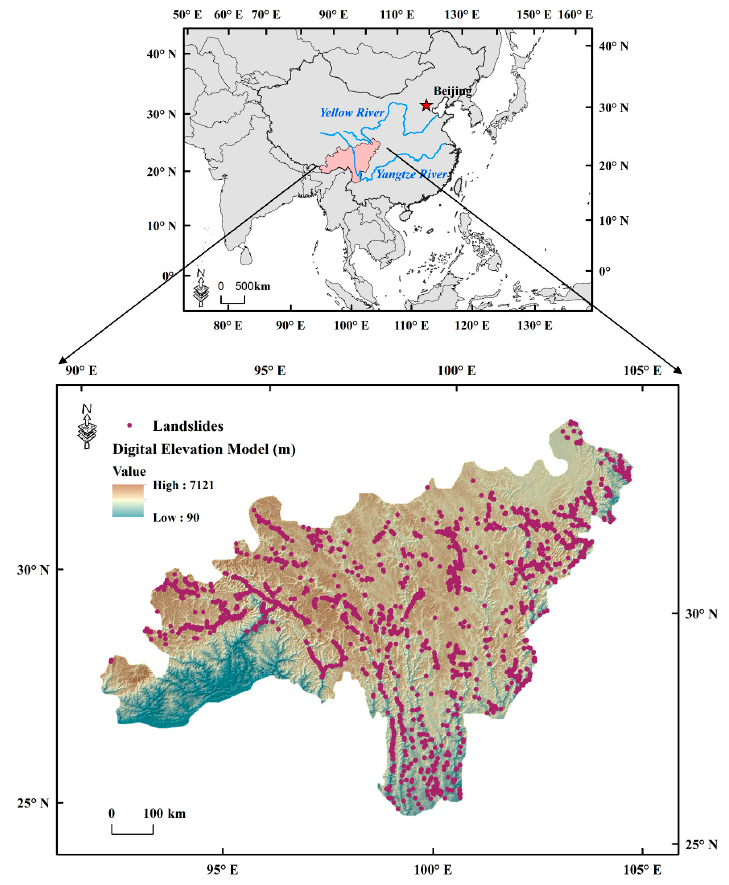
Figure 1. Study area and historical landslide data.